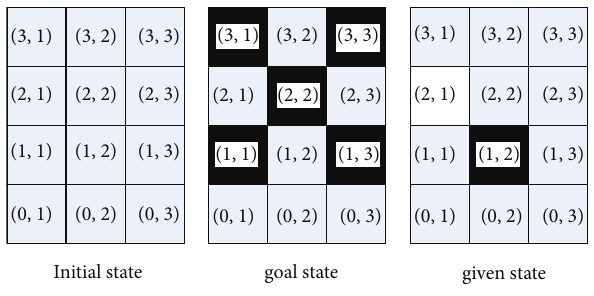
Figure 1: Floortile domain in IPC